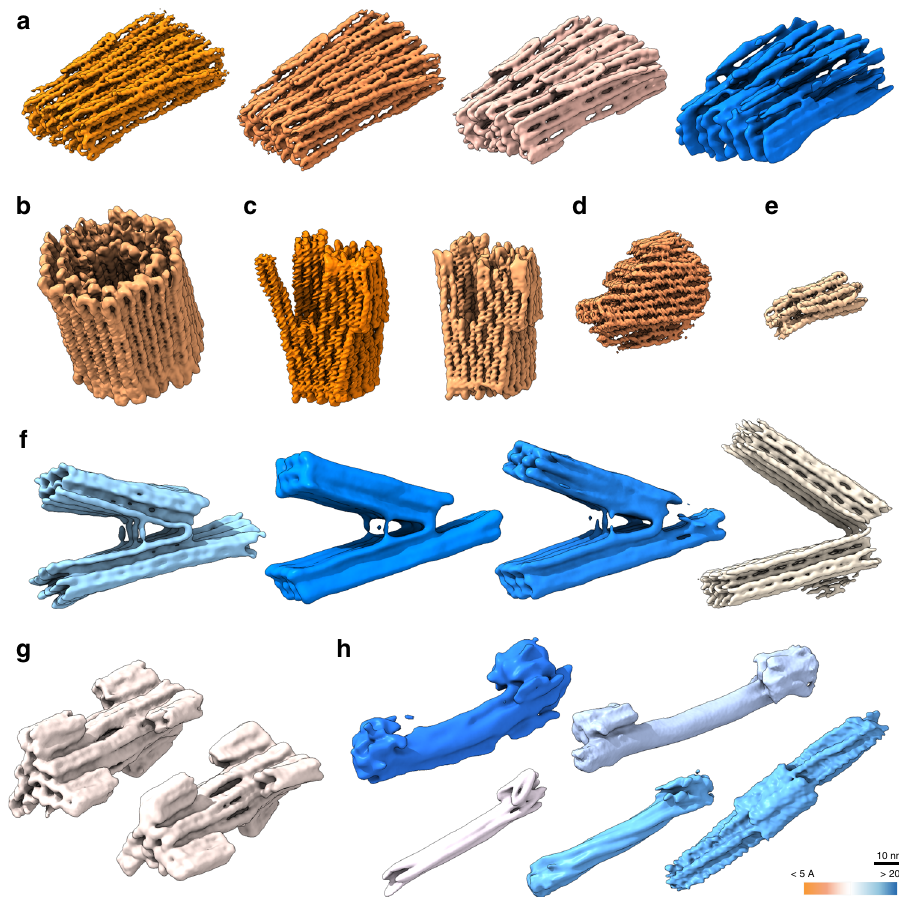
Fig. 1 Twenty DNA origami cryo-EM solution structures drawn to scale. All maps were determined in freestanding ice. a Four 48-helix Brick DNA origami objects. Left to right: 0, 1, 2, 4 unpaired thymidines added at each staple crossover, respectively. b A barrel-like 126-helix bundle DNA origami object one- pot assembled with two scaffold chains. c Two design variants of a multidomain square-lattice DNA origami called Twisttower. d A design variant (v2) of the previously reported Pointer 13 . e A 16-helix bundle DNA origami object assembled from a 1317 base-pair long-scaffold strand. f Four variants of a previously described hinged-beam-like object 23 . g Two variants of a dumbbell-like DNA origami object with a crossover-free handle segment. h Four six- helix bundle DNA origami objects, two with one asymmetric feature at one end (bottom), two with two asymmetric features at each end. Bottom right: a ten-helix bundle with one asymmetric feature in the middle. See Supplementary Figs. S1 – 20 for more cryo-EM imaging details. Strand diagrams for each object are supplied in Supplementary Figs. S43 –